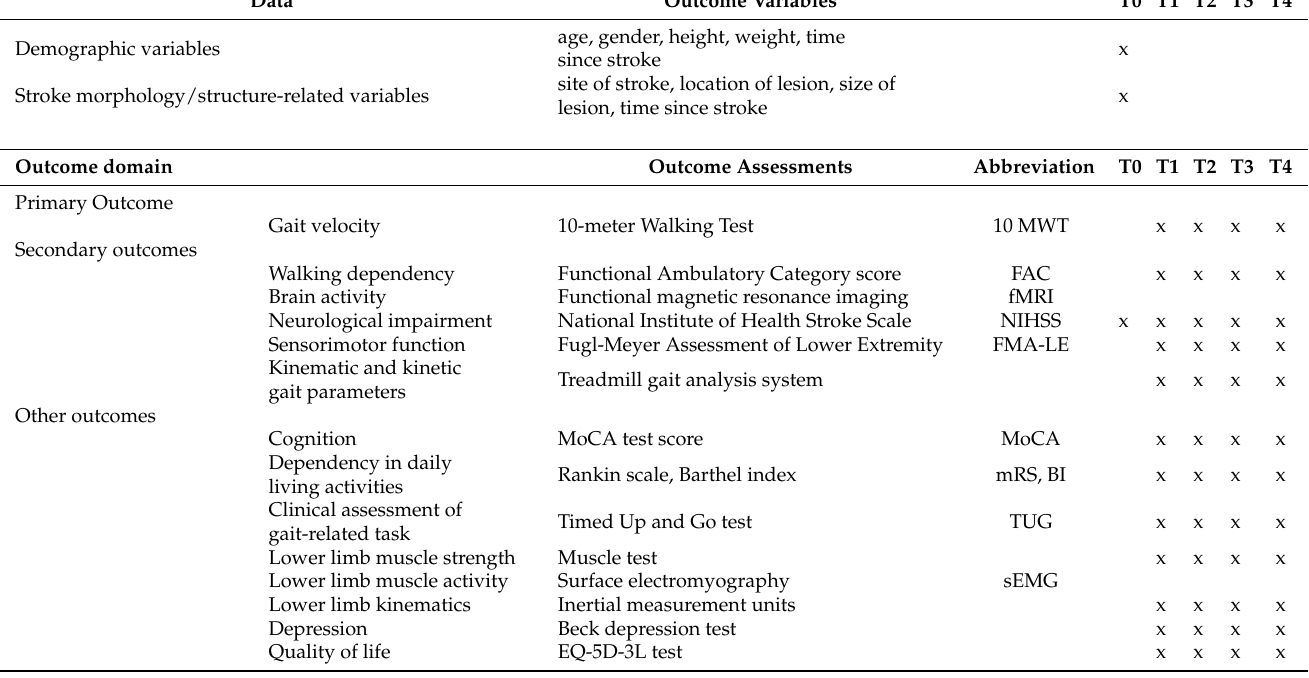
Table 2. Overview of outcome variables and outcome assessments throughout the study